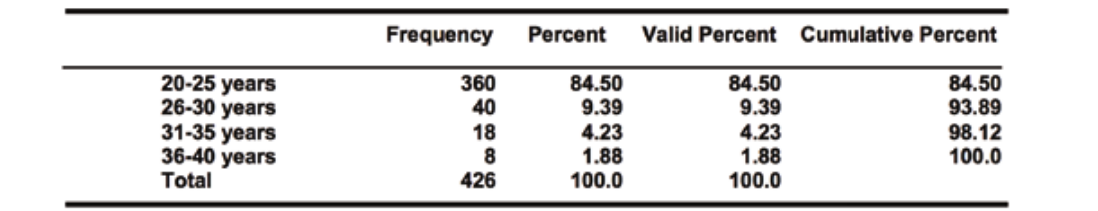
Table 2: Frequency table for various Age Groups